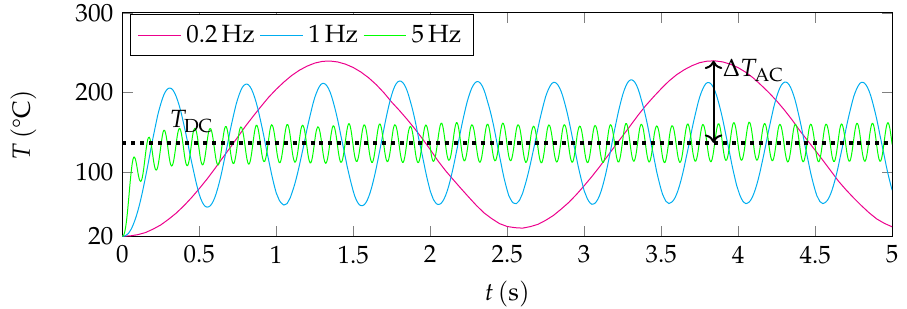
Figure 2. Temperature oscillations for different input current frequencies in ambient air as a function of time in the time-dependent study. The DC-component of the heater temperature T DC is constant, whereas the amplitudes of the temperature oscillation T AC depend on the frequency. The amplitude ∆ T AC for a frequency of 0.2Hz is marked exemplarily. According to the explanation in Section 2, the temperature oscillations exhibit twice the frequency than the sinusoidal input